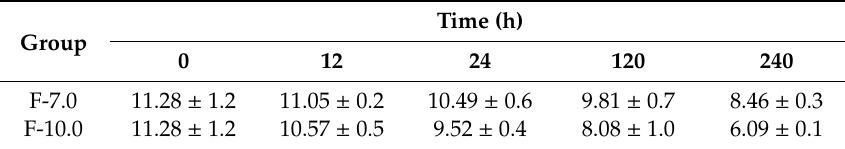
Table 2. Time profiles of VSS reduction during the anaerobic fermentation (g / L).